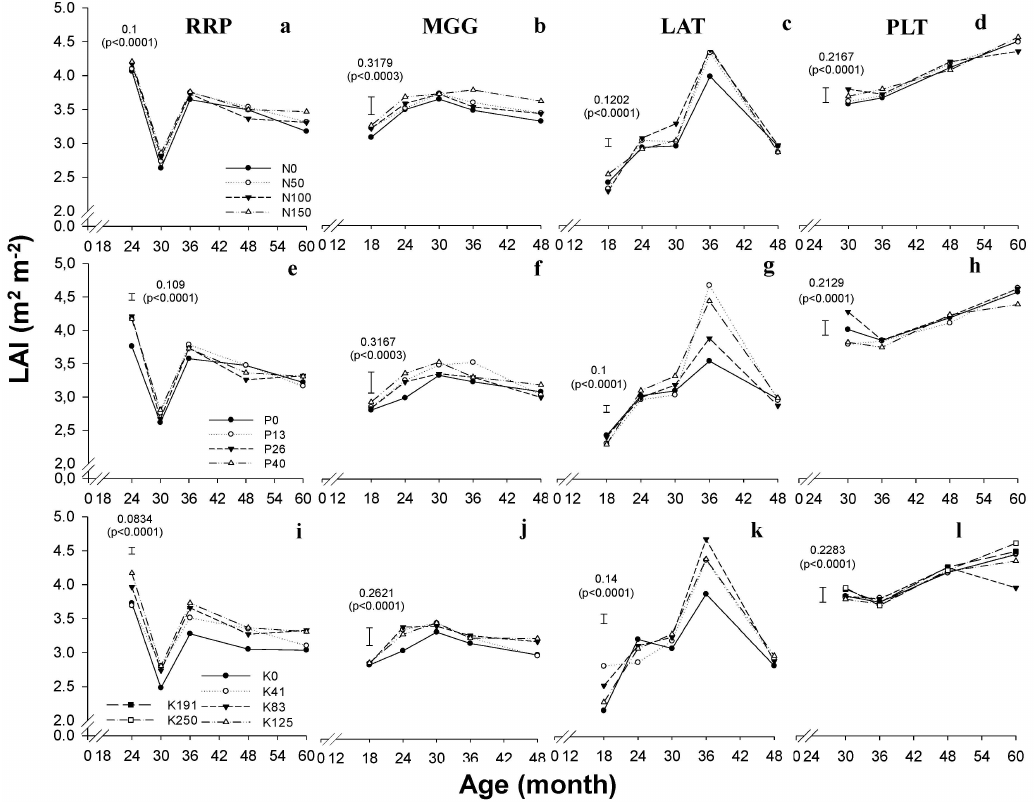
Figure 3. Leaf area index of N ( a – d ), P ( e – h ) and K( i – l ) for RRP ( a,e,i ), MGG ( b,f,j ), LAT ( c,g,k ) and PLT ( d,h,l ), according to the applied rates of the nutrients and the plantation age. Bars indicate the least significant difference by the LSD test ( p <